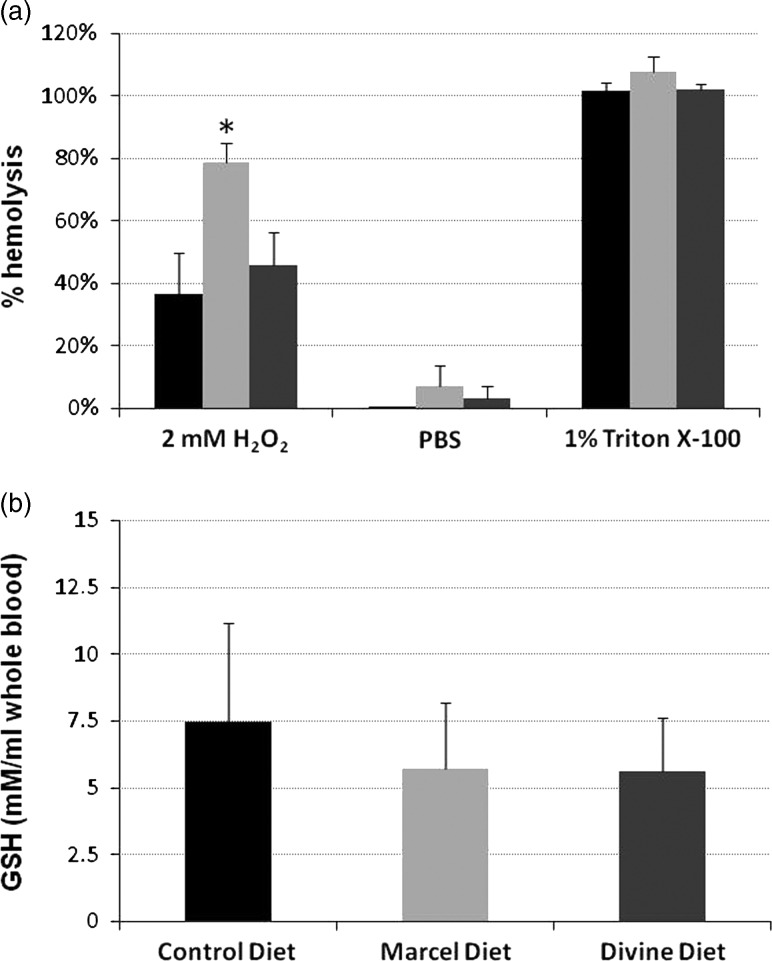
Screening assay for red blood cells (RBC) redox sensitivity (a) and measurement of Glutathione (GSH) levels in RBCs (b) from hens of trial 1. (a) Hen RBCs were incubated on microplate shaker (1000 r.p.m.) for 12 h in the dark at room temperature in the presence of 2 mM H2O2 after 2 weeks of control soybean diet (black bars), or a diet supplemented with 20% high vicine (V)+convicine (C) faba beans (Marcel beans, light gray bars) or a diet supplemented with 20% low V+C faba beans (Divine beans, dark gray bars). The same RBCs were incubated for 12 h under the same conditions: as a negative control in phosphate-buffered saline (PBS) only, or as a positive control with 100% hemolysis after addition of 1% Triton X-100. Column data represent mean values±SD of four independent experiments analyzed for statistical significance by two-sided Student’s t-test. Percentage of hemolysis in RBCs from hens fed the high V+C diet was significantly higher than in control RBCs (*P<0.002) and those from hens fed the low V+C diet (*P<0.003). (b) GSH levels (expressed as mmoles/ml whole blood) were measured in hen RBCs after 1 week of control, Marcel (high V+C) or Divine (low V+C) diet. For details, see (a) and Materials and Methods section.